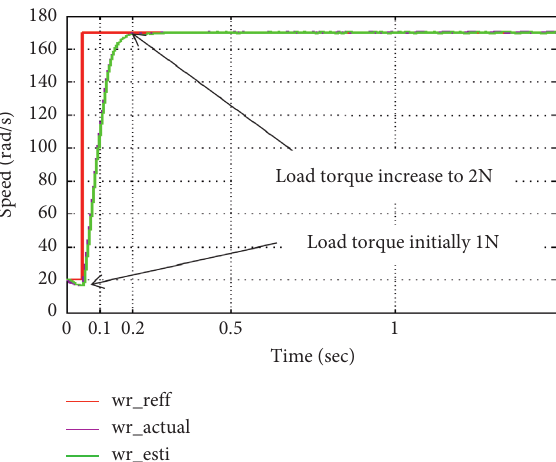
Figure 10: Load torque effect on stator current-based MRAS.